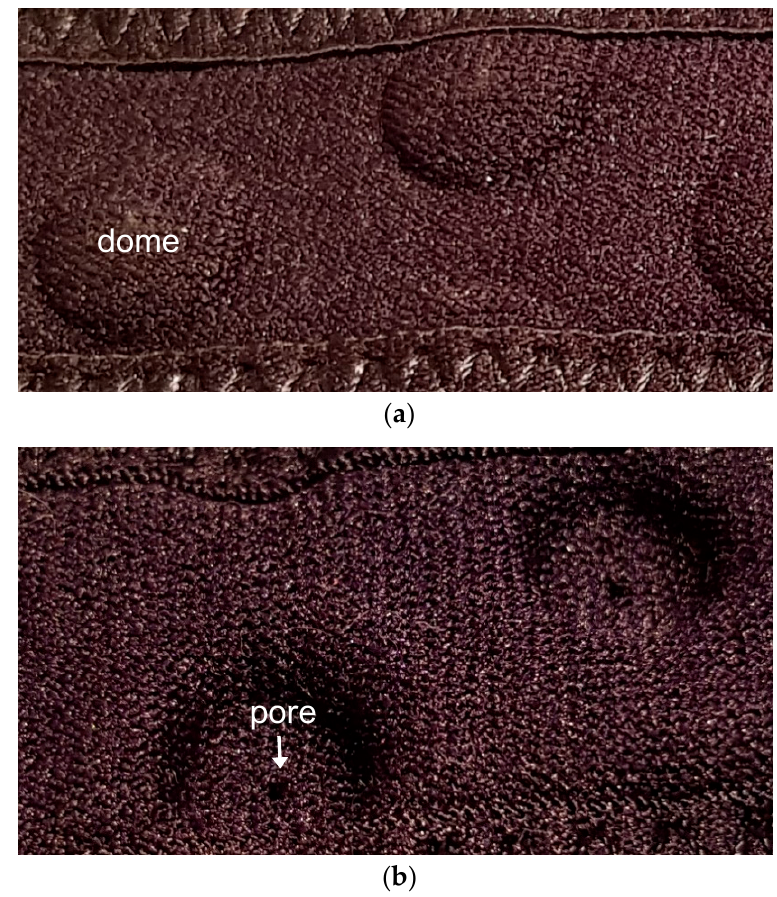
Figure 1. ( a ) Front view and ( b ) reverse view of Stomatex ® fabric showing the fabric domes and the pore at the dome apex.